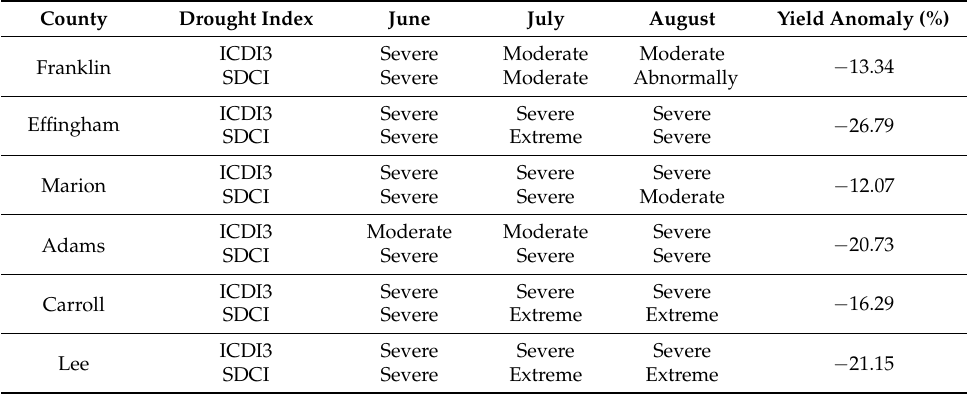
Figure 10. The distribution of corn yields of Marion, Adams, and Carroll during 2004–2019. Table 6. Drought indices in summer and the corn yield anomalies in 2005.